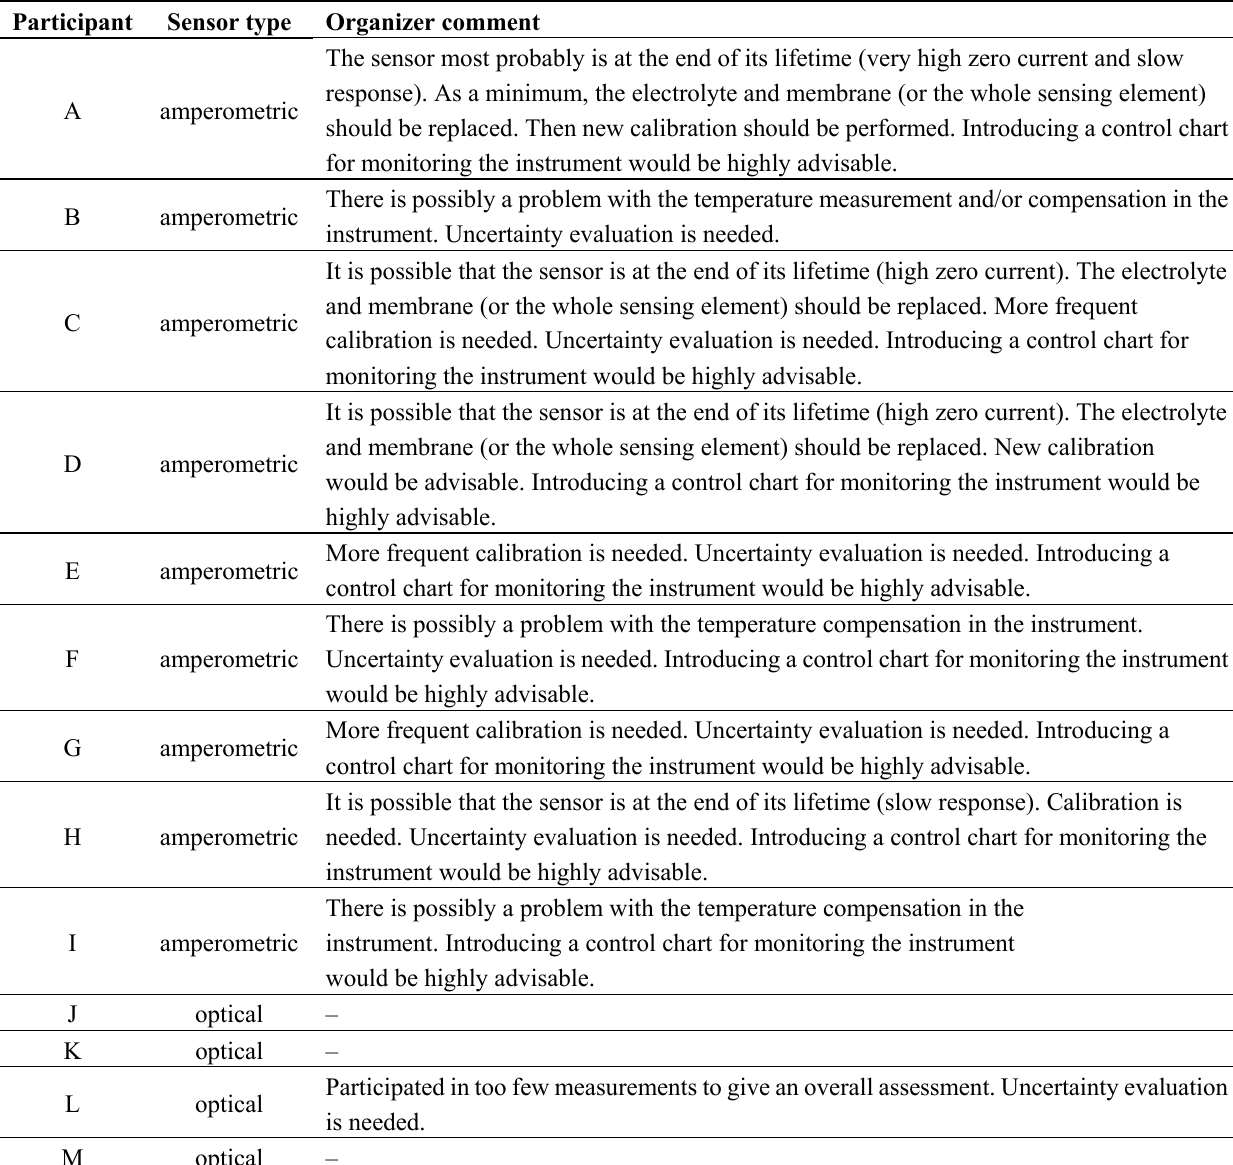
Table 15. Comments and recommendations of the organizer to the